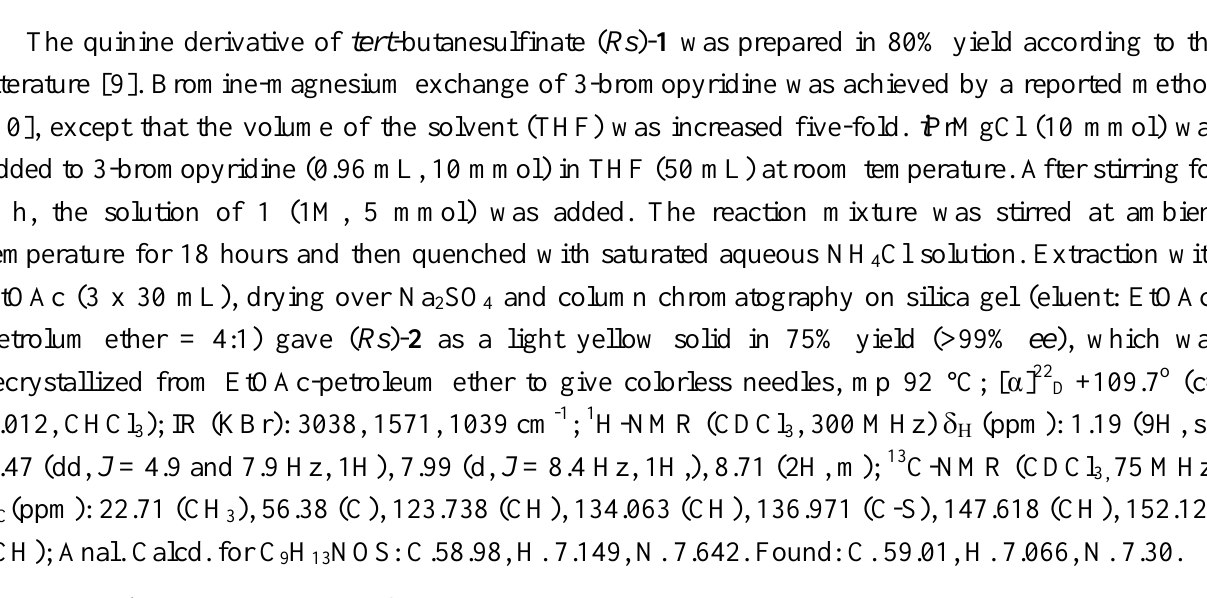
Figure 3. Resolution of compound 2 by HPLC with OB-H chiral stationary